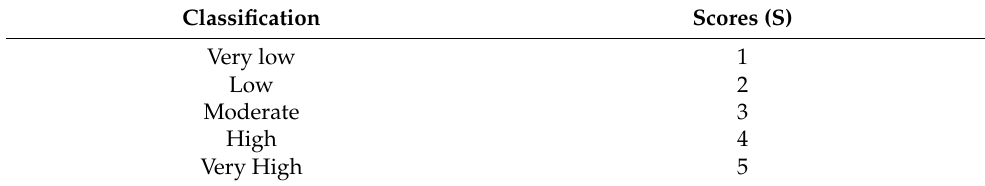
Table 9. Score values of the classification.